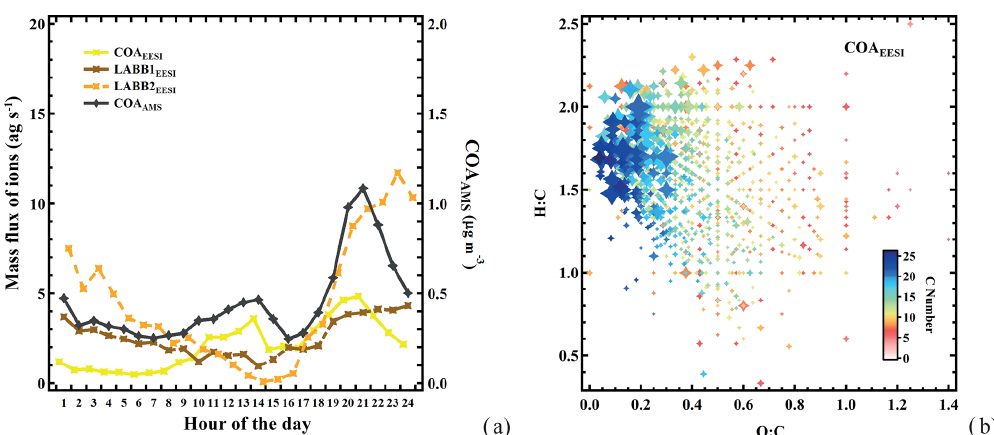
Figure 3. (a) Diurnal cycles of the EESI-TOF-MS less aged biomass burning and cooking factors, together with AMS cooking. (b) Van Krevelen plot (atomic H : C vs. O : C of each neutral compound) for the COA EESI factor mass spectrum, with points sized by the fraction of each neutral compound apportioned to COA EESI and colored by number of carbon atoms.